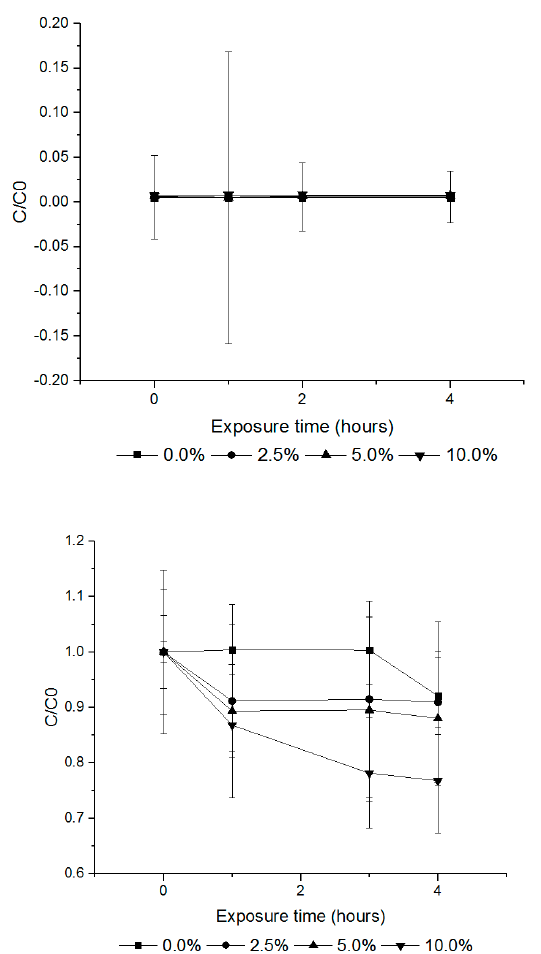
Figure 6. The amount of PH 3 + EF loss according to the different loading ratios of cured tobacco leaves (control, 2.5%, 5.0% and 10.0% ( w/v )). Each value represents the mean ± SE ( n = 3). C/C0 is the ratio of the concentration of the fumigant in the headspace.